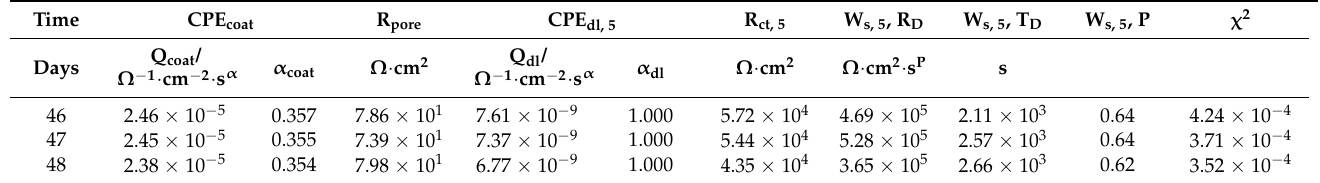
Table 8. Fitted values of EEC components for a coating prepared from the formula Zn–80%-PC, Stage